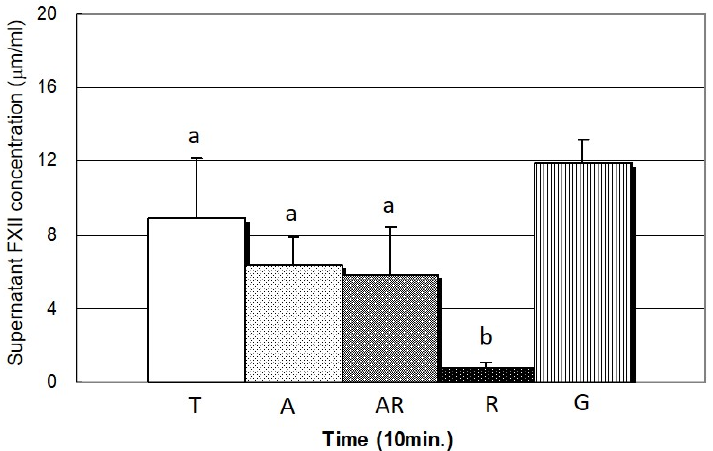
Figure 5. FXIIa concentrations in supernatant, calculated at 10 min from test specimens. The amount of FXIIa in supernatant of R group was the least ( p < 0.05), indicating amount of FXIIa on surface of R specimen was the highest (groups with different lowercase letters are significantly different ( p < 0.05)).